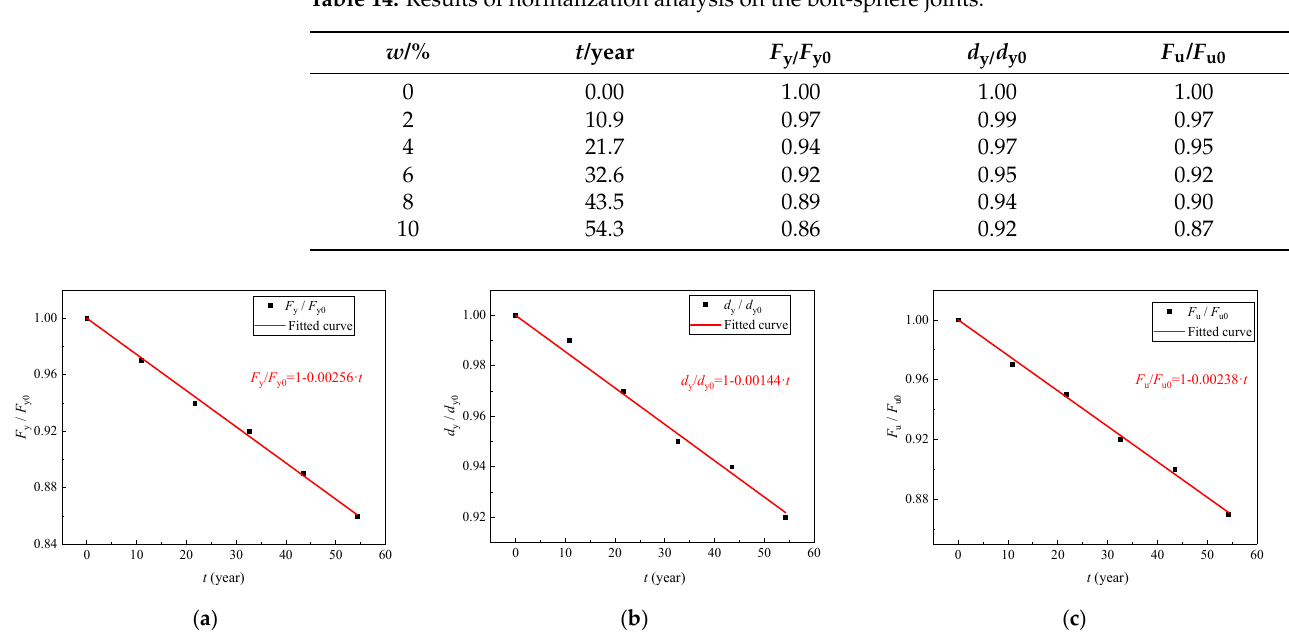
Table 14. Results of normalization analysis on the bolt-sphere joints.